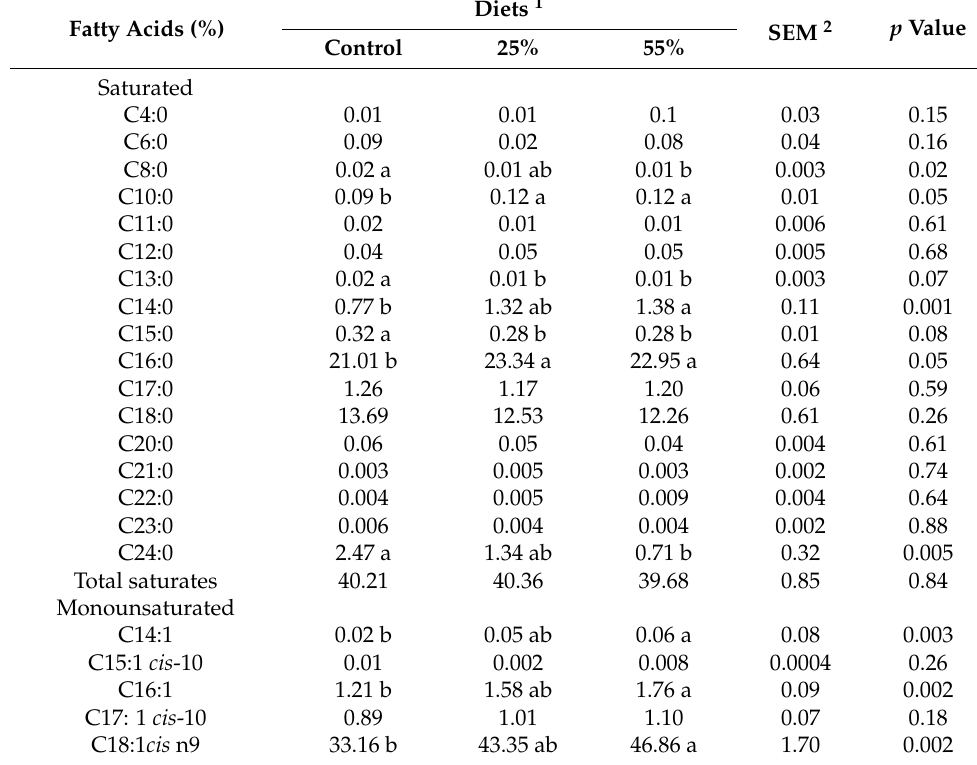
Table 5. Fatty acid profile of the Longissimus lumborum muscle of goats fed forage cactus as a substitute for Tifton 85